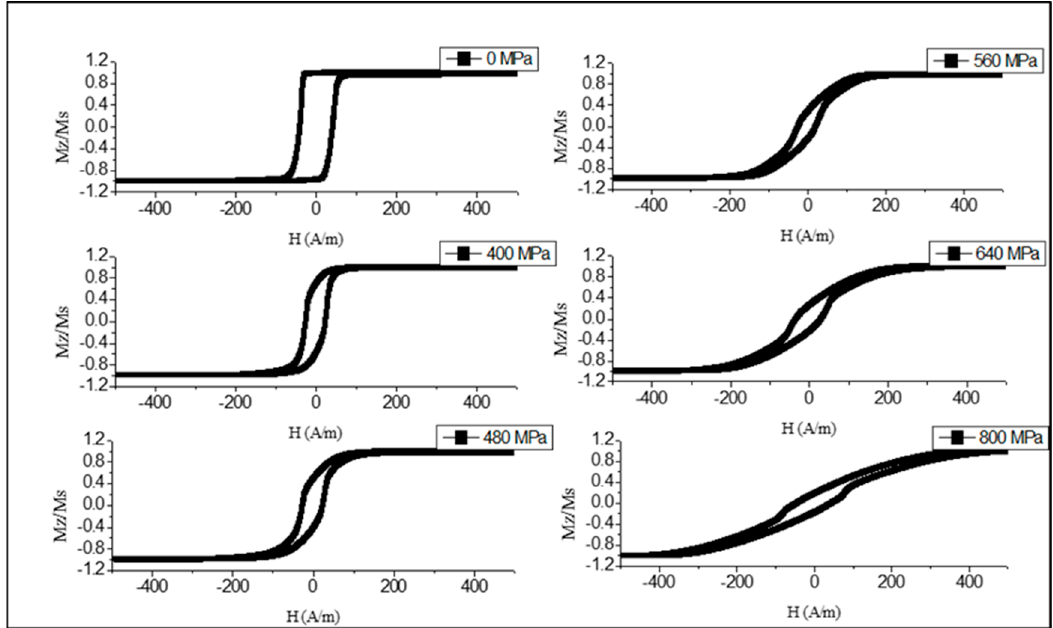
Figure 4. Effect of tensile stress on hysteresis loops of glass-coated amorphous Co 71 Fe 5 B 11 Si 10 Cr 3. microwires in the as-prepared state.